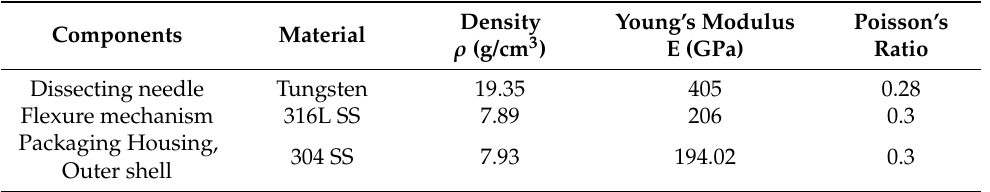
Table 2. Material properties of the microdissection device with a flexure mechanism.